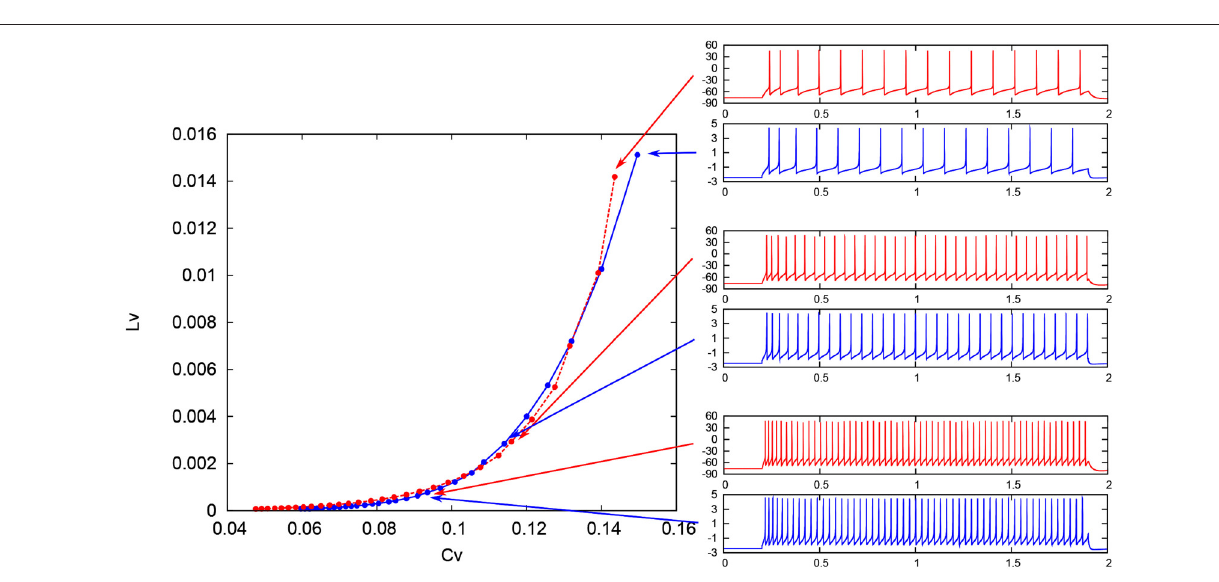
FIGURE 12 | Spike sequences and their representation in the C V − L V plane. The L V vs. C V for spike sequences generated by the Pospischil (red) and the DSSN (blue) models in the excitatory RS mode in response to various magnitudes of step input.